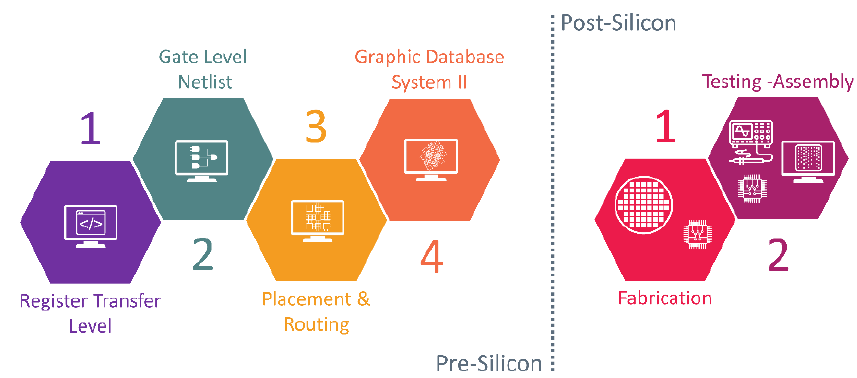
Figure 2. Overview of ASIC production chains.